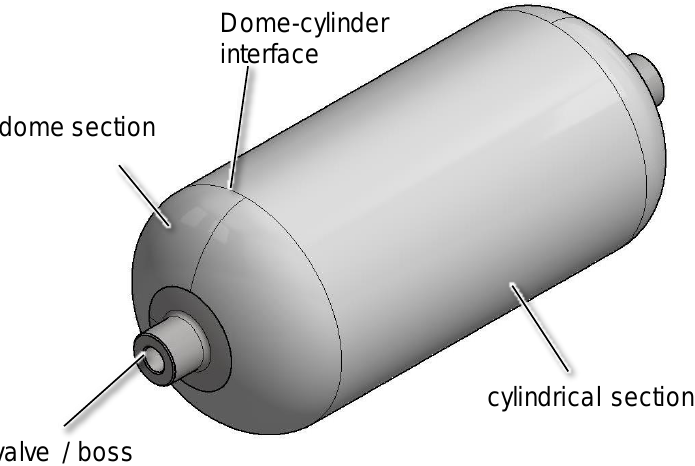
Figure 1. Sections of a polymer liner/mandrel with boss